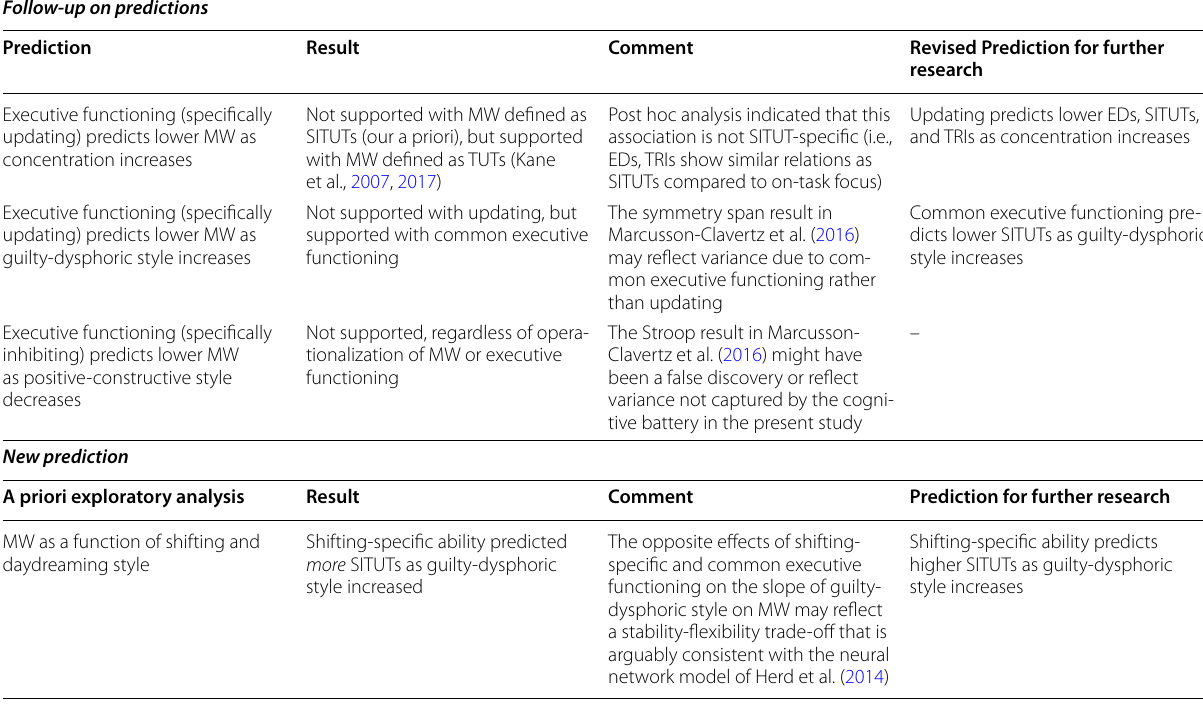
Table 6 Summary of results concerning predictions of mind wandering (MW) as a function of concentration and